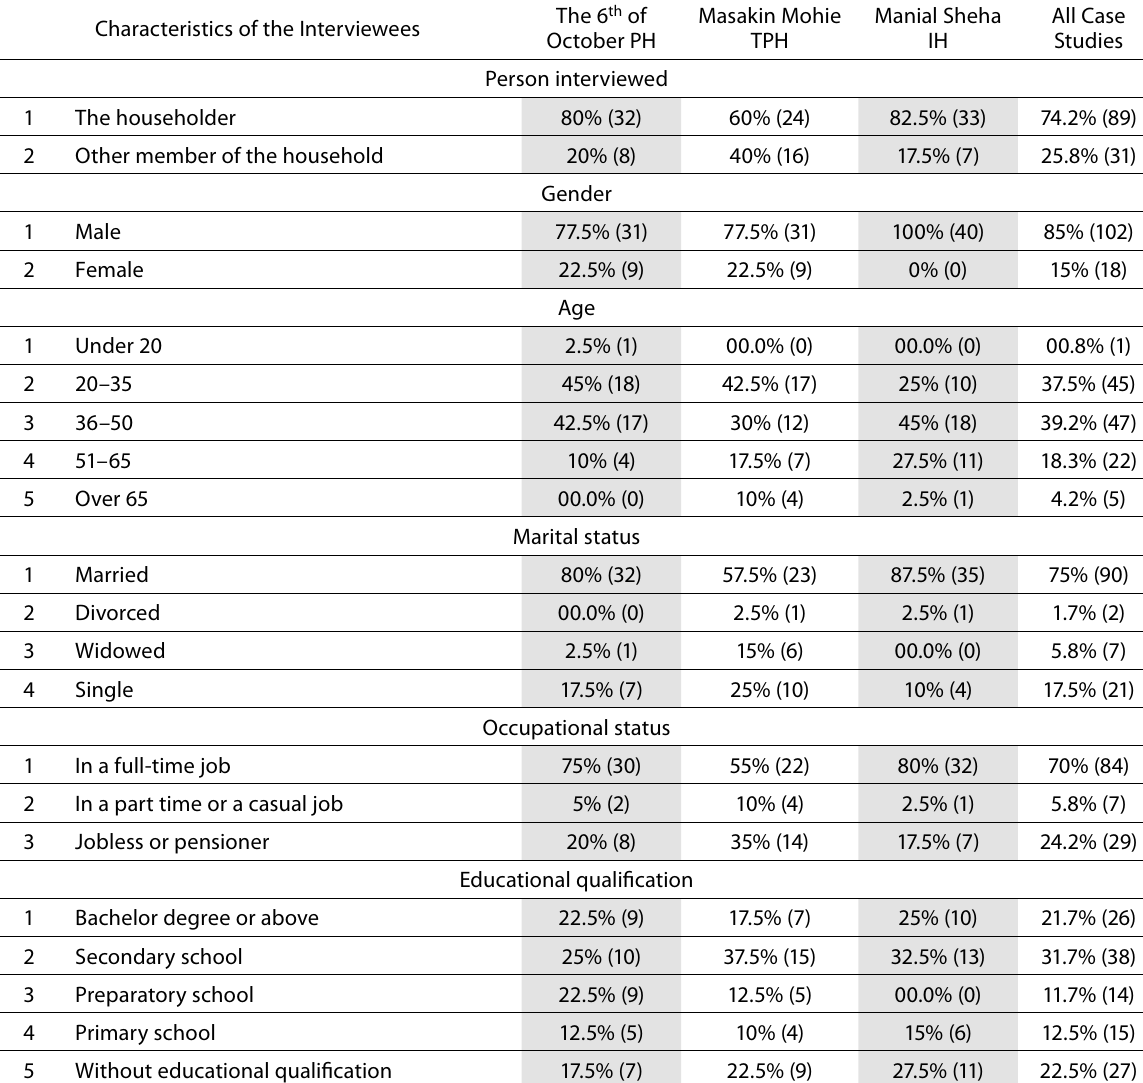
Table 1. Characteristics of the interviewees in the three case studies Characteristics of the